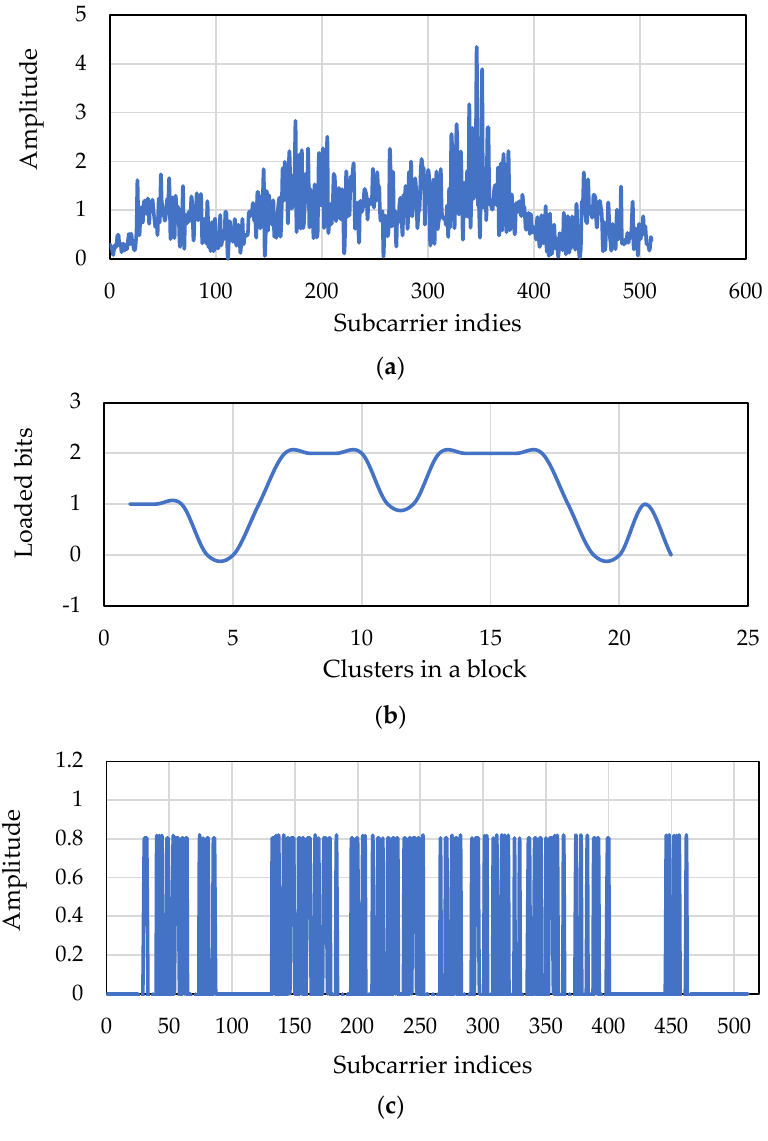
Figure 19a,b show the CFR of an OFDM block of a received frame and respective